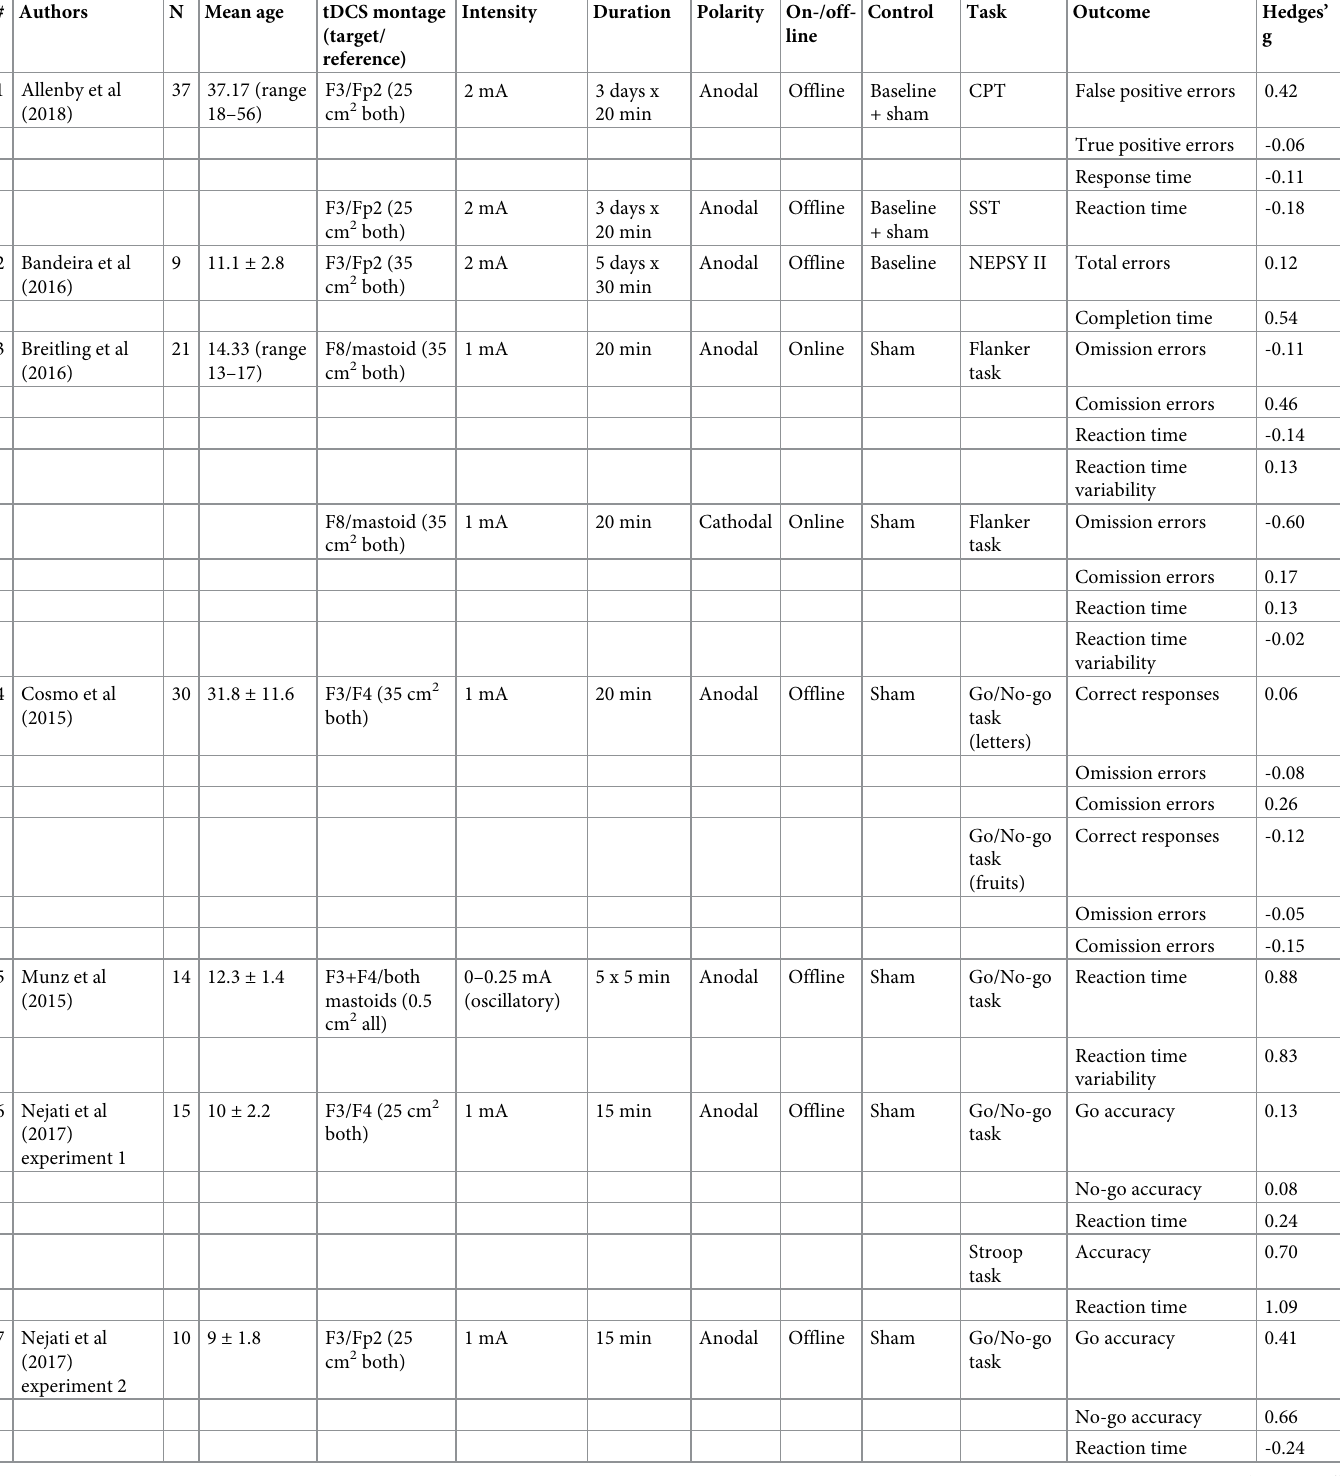
Table 1. Characteristic of studies included in meta-analysis for the effecs of tDCS on inhibitory